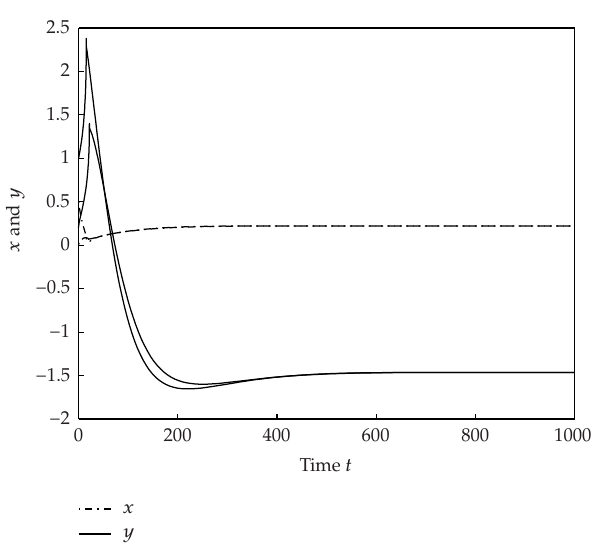
Figure 2: Solution curves for R 0 (cid:8) − 0 . 5 with initial value (cid:5) 0 . 01 , 0 . 2 (cid:6) , (cid:5) 0 . 5 , 1 (cid:6) .